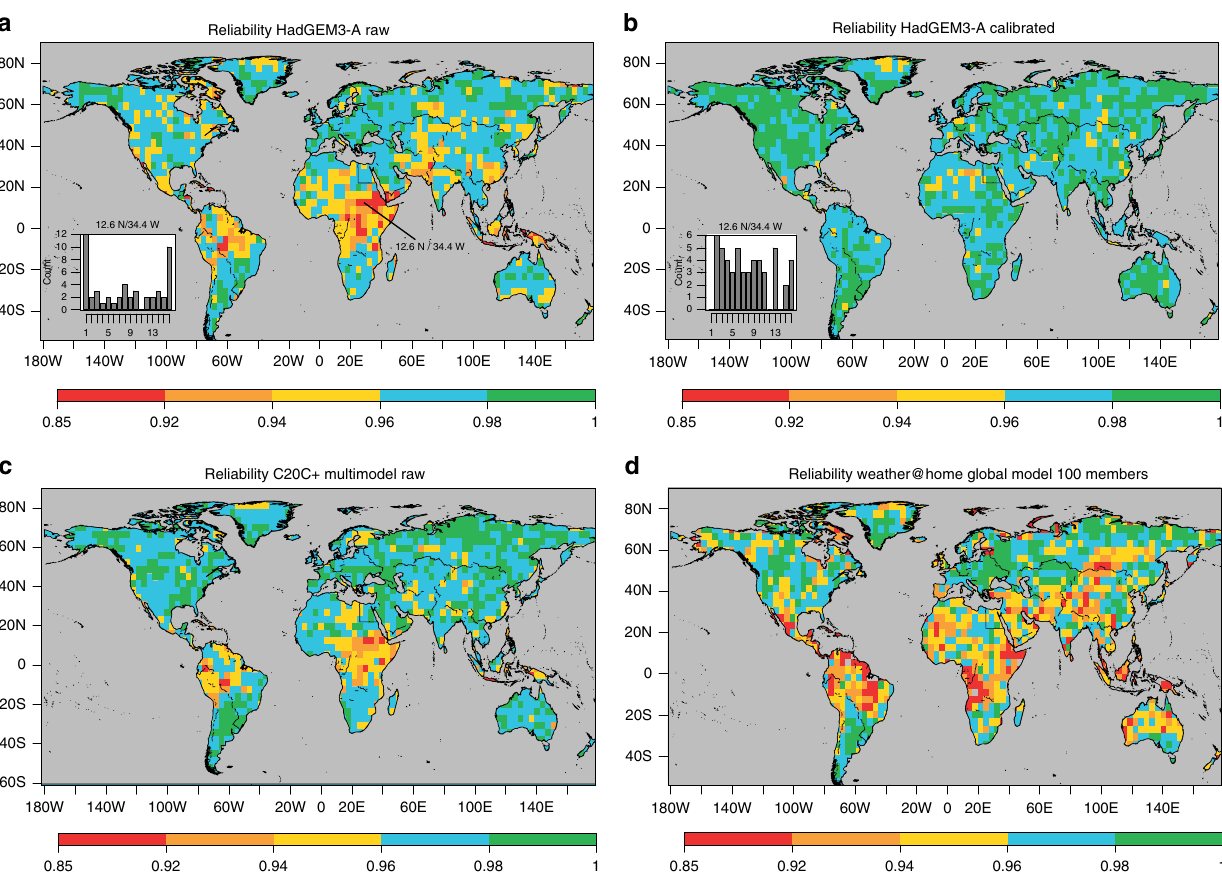
Fig. 2 Reliability of event attribution experiments to simulate probabilities of high temperatures during boreal summers. The reliability measures the accuracy of simulated probabilities and a value of one denotes perfect reliability (see methods reliability assessment). Reliability is shown for a the single- model ensemble of the UK quasi-operational attribution system (HadGEM3-A), b the single-model system (HadGEM3-A) after the ensemble calibration, c the multi-model event attribution system of Climate of the 20th Century Plus project (C20C + ) and d a 100-member ensemble of the weather@home project using HadCM3 23 . The small boxes in panels a and b denote the ranked histogram (counts of the position where the observations fall in the ensemble over the historical period) for the grid point denoted in panel a over Sudan analysed in Fig.